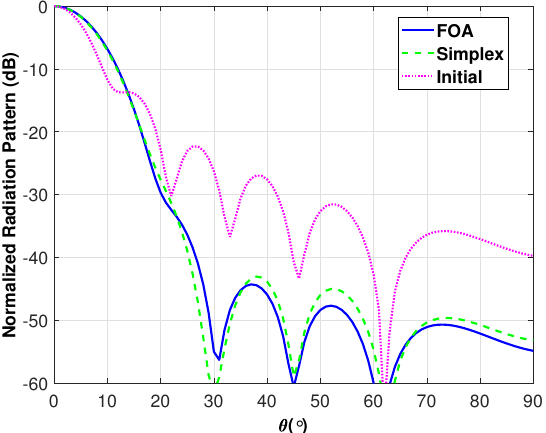
Figure 8. Normalized radiation pattern at 94 GHz of the of the optimized Potter Horn (E-Plane).